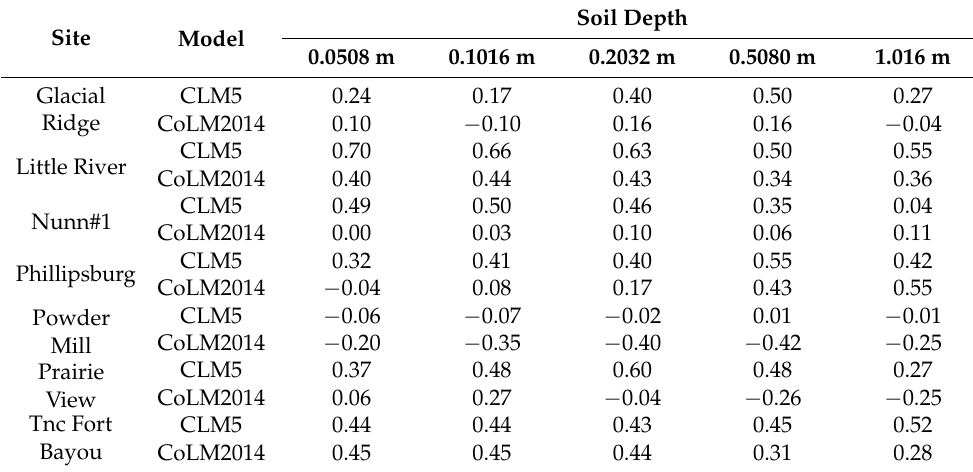
Figure 6. Simulated and observed temporal soil moisture variation at the SCAN sites for 2010–2014 at a soil depth of 1.0160 m. The blue line is the CLM5 simulation, the red line is the CoLM2014 simulation, the dashed line is the observation, and the yellow bars are the daily cumulative precipitation. ( a – g ) Glacial Ridge, Little River, Nunn#1, Phillipsburg, Powder Mill, Prairie View, and Tnc Fort Bayou, respectively. Table 2. Correlation coefficients between simulated and observed soil moisture at selected SCAN